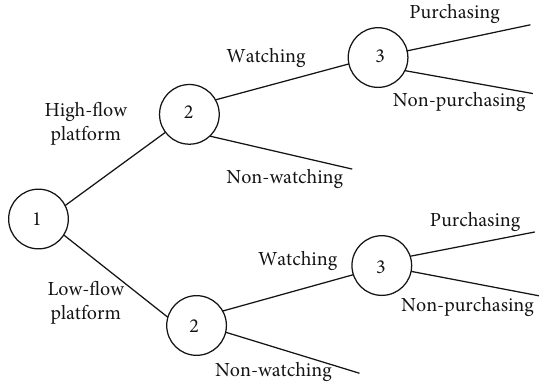
Figure 4: The game between the platform partners and the end